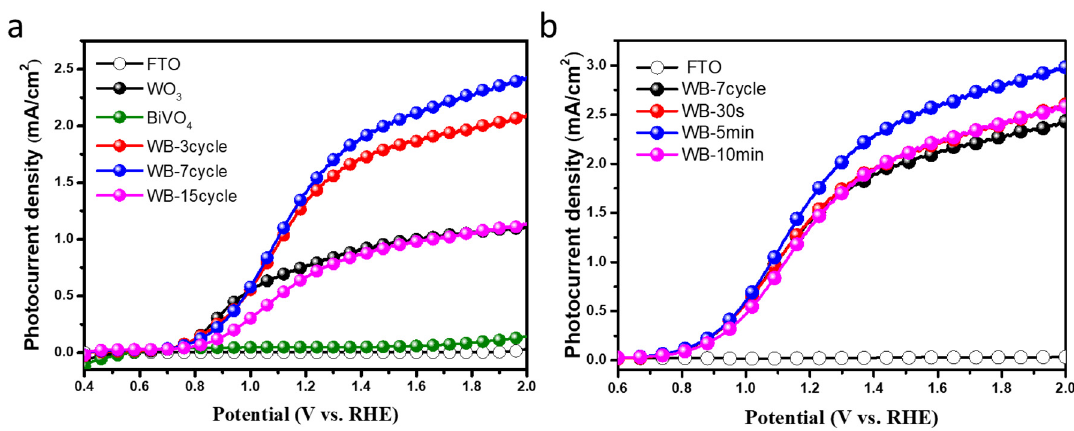
Figure 4. I-V curves for ( a ) FTO, WO 3 , BiVO 4 , WB-3cycle, WB-7cycle, and WB-15cycle samples and ( b ) FTO, WB-7cycle, WB-30s, WB-5min, and WB-10min samples.